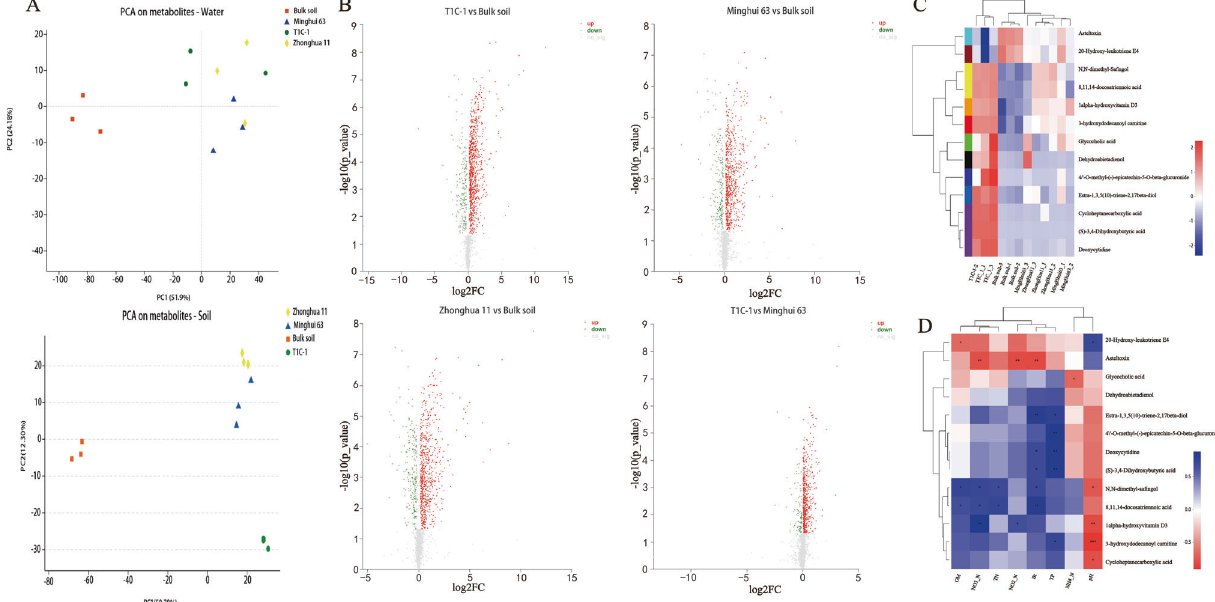
Fig. 5 Metabolomic analysis of soil and surface water samples. A Principal component analysis (PCA) of soil and surface water metabolomic pro fi les based on Bray – Curtis distances. B Relative abundances of different metabolites. The volcano plot was obtained by plotting the log2 fold change of metabolites on the x -axis and the – log10 ( p value) on the y -axis. Metabolites that increased twofold or more with a p < 0.05 from paired samples are indicated in red. Metabolites that decreased twofold or more with p < 0.05 from a pair samples are indicated in green. The other metabolites are indicated in gray. C Heatmap cluster analysis of the 13 representative metabolites in the rhizosphere samples of T1C-1 relative to the other samples. A dendrogram was generated for the samples to show sample differences and is indicated on the left side of the heatmap. Sample similarities were calculated using Bray – Curtis distances. D Correlations between representative metabolites and soil physicochemical